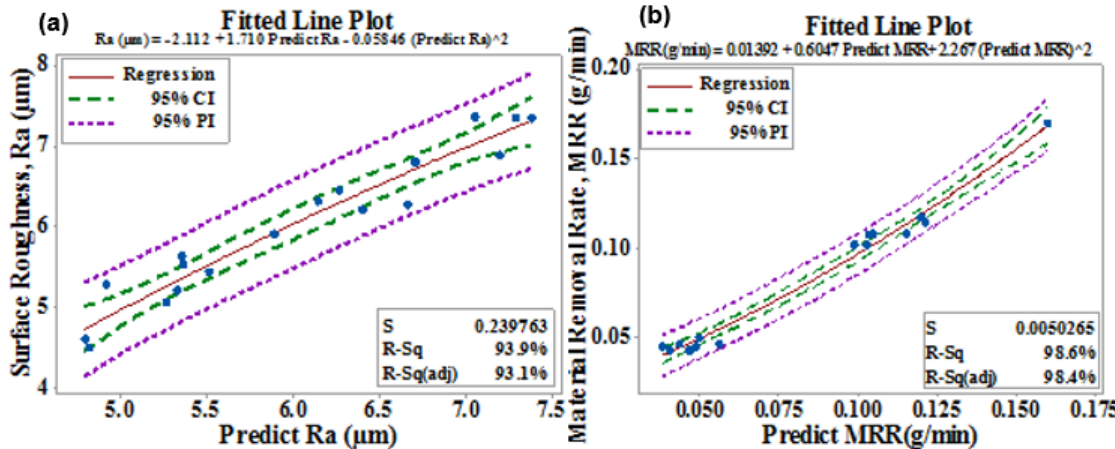
Figure 11. Comparison of predicted values and experimental results for output parameters: ( a ) average surface roughness, ( b ) MRR. (CI: confidel interval, PI: predict interval).